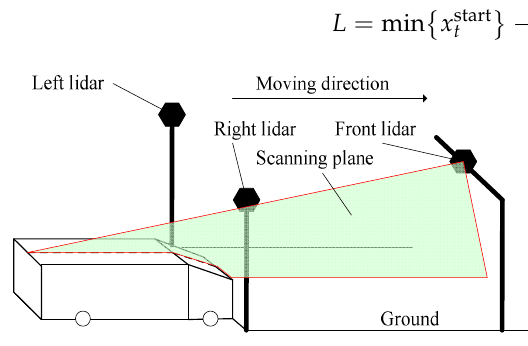
Figure 7. State of t start .